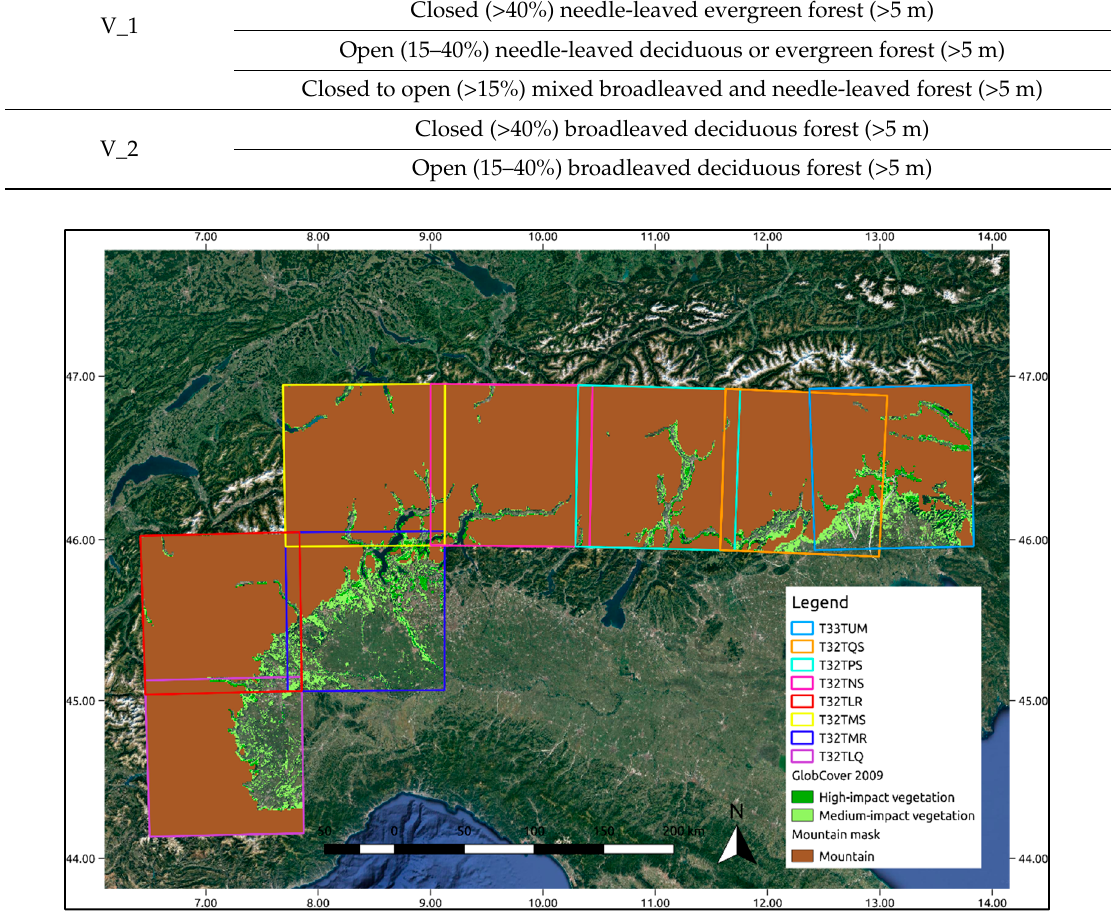
Figure 4. Selection of S-2 tiles over Italian Alps.